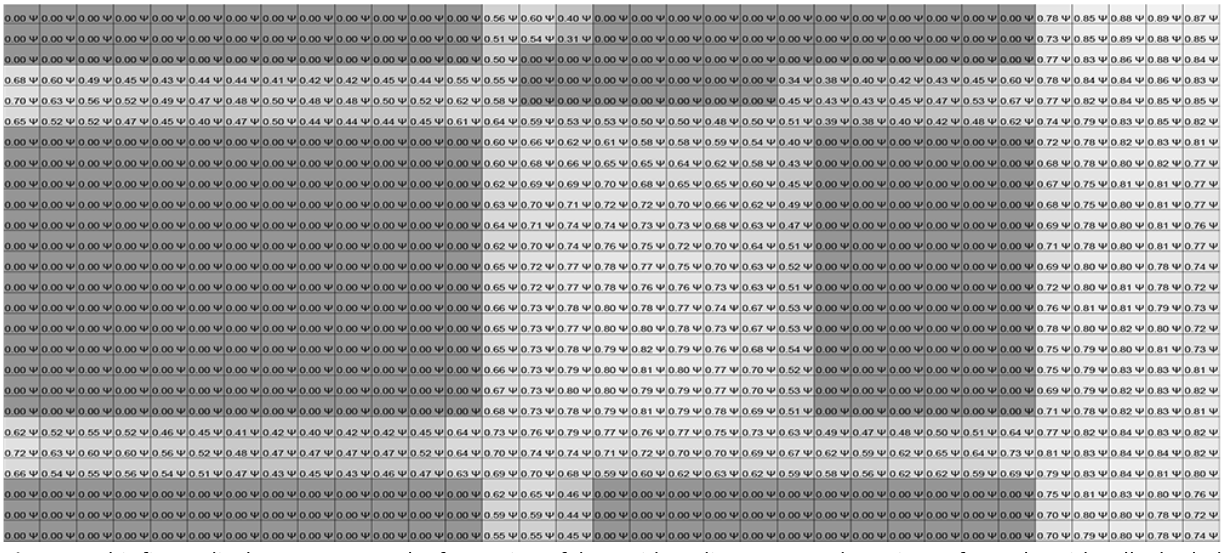
Figure 4. This figure displays a screen grab of a portion of data grid readings exported to Microsoft Excel™ with cells shaded based on SVF value. Note that inside buildings, SVF = 0 (this is due to windows and internal walls not being modelled in the test